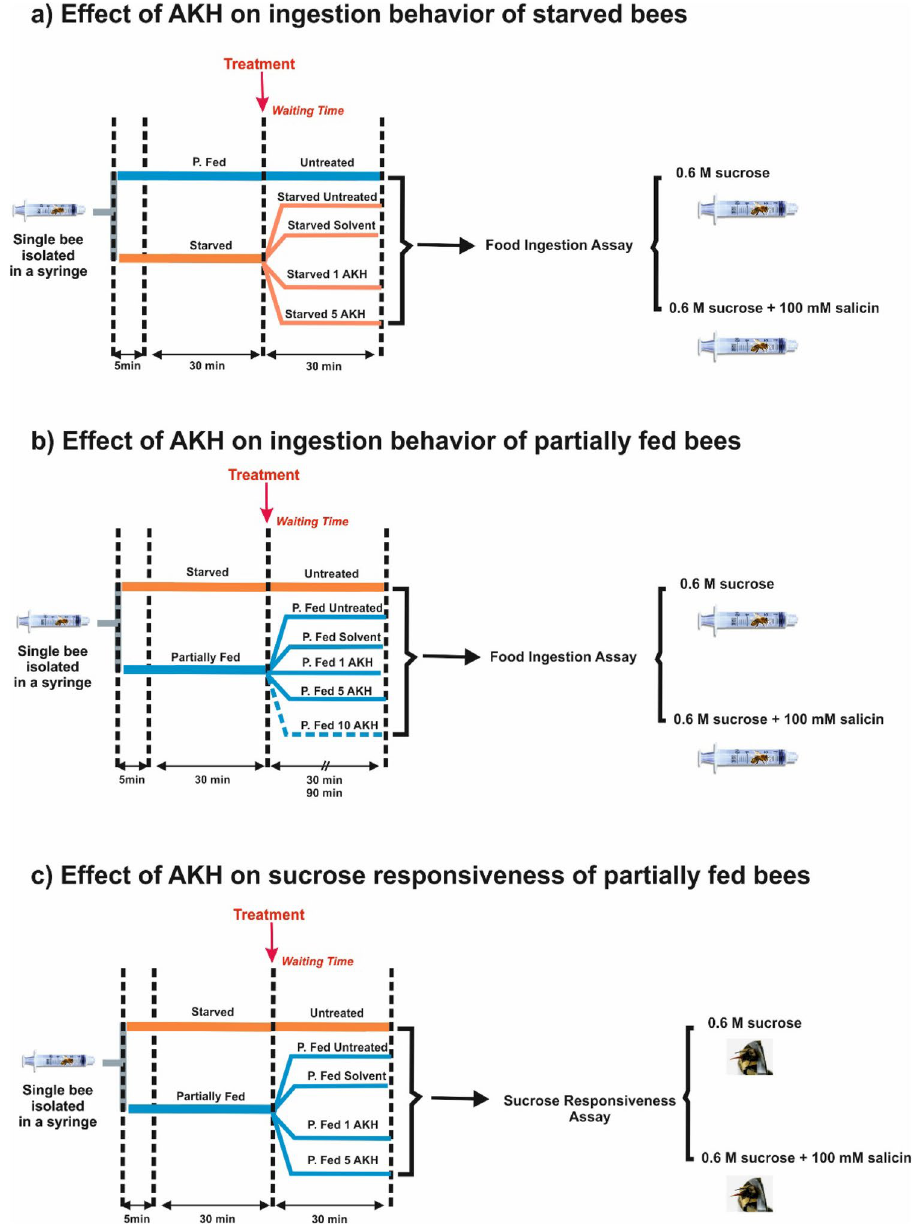
Figure 1. Experimental protocols applied to partially fed and starved bees. Honey bee foragers were enclosed in individual syringes during 5 min. They then received two feeding treatments during the next 30 min: starved bees (‘Starved’) received no food while partially fed bees (‘P. Fed’) received 5 µl of honeydew (a mixture of 10 ml of distilled water, 30 g of honey, 5 g of pollen and 5 g of sugar) and then 20 µl of 1.8 M sucrose solution. ( a ) Effect of AKH on food-ingestion of starved bees. After topical application and an additional resting period of 30 min, bees were maintained in their syringes and food was delivered by means of a 100–200 µl Eppendorf tip inserted in the syringe during a 1-h period. Four groups of starved bees and one group of partially fed bees were run in parallel. The group of partially fed bees (‘P. Fed’) and one group of starved bees (‘Starved’) remained untreated (controls). The remaining three groups of starved bees were subjected to different treatments: one was topically exposed with the solvent used as vehicle for AKH (‘Starved Solvent’) while the other two were topically exposed with either 1 µg/µl (‘Starved 1 AKH’) or 5 µg/µl (‘Starved 5 AKH’) of AKH solution. Bees were offered either 100 µl of a 20% (0.6 M) pure sucrose solution or 100 µl of a mixture of 20% (0.6 M) sucrose solution and 100 mM salicin. ( b ) Effect of AKH on food-ingestion of partially fed bees. After topical application and an additional resting period of either 30 min or 90 min, bees were maintained in their syringes and food was delivered by means of a 100–200 µl Eppendorf tip inserted in the syringe during a 1-h period. Six groups of bees were established for the 30-min resting period (Starved, P. Fed, P. Fed Solvent, P. Fed 1 AKH, P. Fed 5 AKH and P. Fed 10 AKH). Five groups were used for the 90-min resting period (Starved, P. Fed, P. Fed Solvent, P. Fed 1 AKH and P. Fed 5 AKH). Bees were fed with either 100 µl of a 20% (0.6 M) pure sucrose solution or 100 µl of a mixture of 20% (0.6 M) sucrose solution and 100 mM salicin. ( c ) Effect of AKH on sucrose responsiveness of partially fed bees. After topical application and an additional resting period of 30 min, bees were subjected to a sucrose-responsiveness assay in which their proboscis extension response (PER) was quantified upon antennal stimulation with a series of increasing concentrations of pure sucrose solution (0.1%, 0.3%, 1%, 3%, 10% and 30% w/w) or the same solutions spiked with 100 mM salicin. Five groups were used: Starved, P. Fed, P. Fed Solvent, P. Fed 1 AKH and P. Fed 5